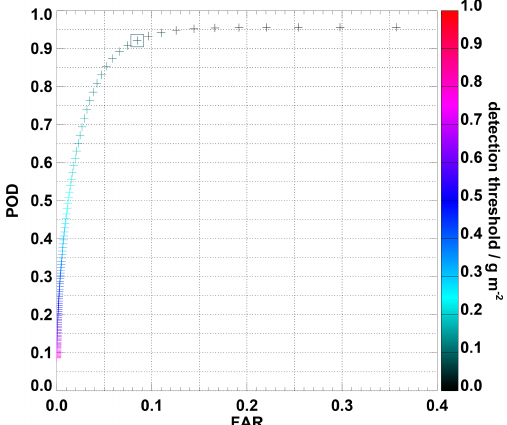
Figure 5. Probability of detection (POD) against false-alarm rate (FAR) depending on the mass load threshold applied. The square marks the position corresponding to the threshold 0.1gm − 2 .